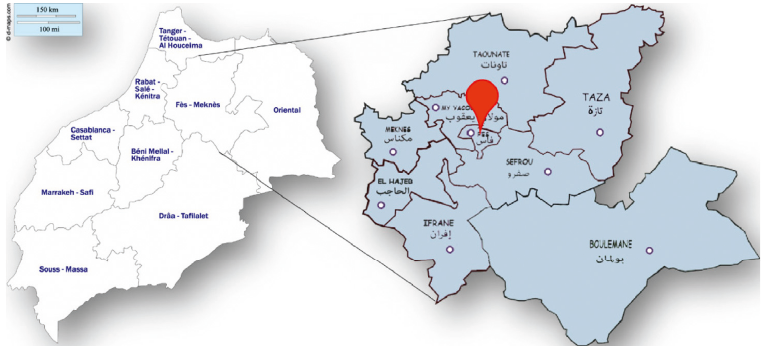
Figure 1: Location of oil moulin Fez MOROCCO. Table 1: Physicochemical characterisation of olive